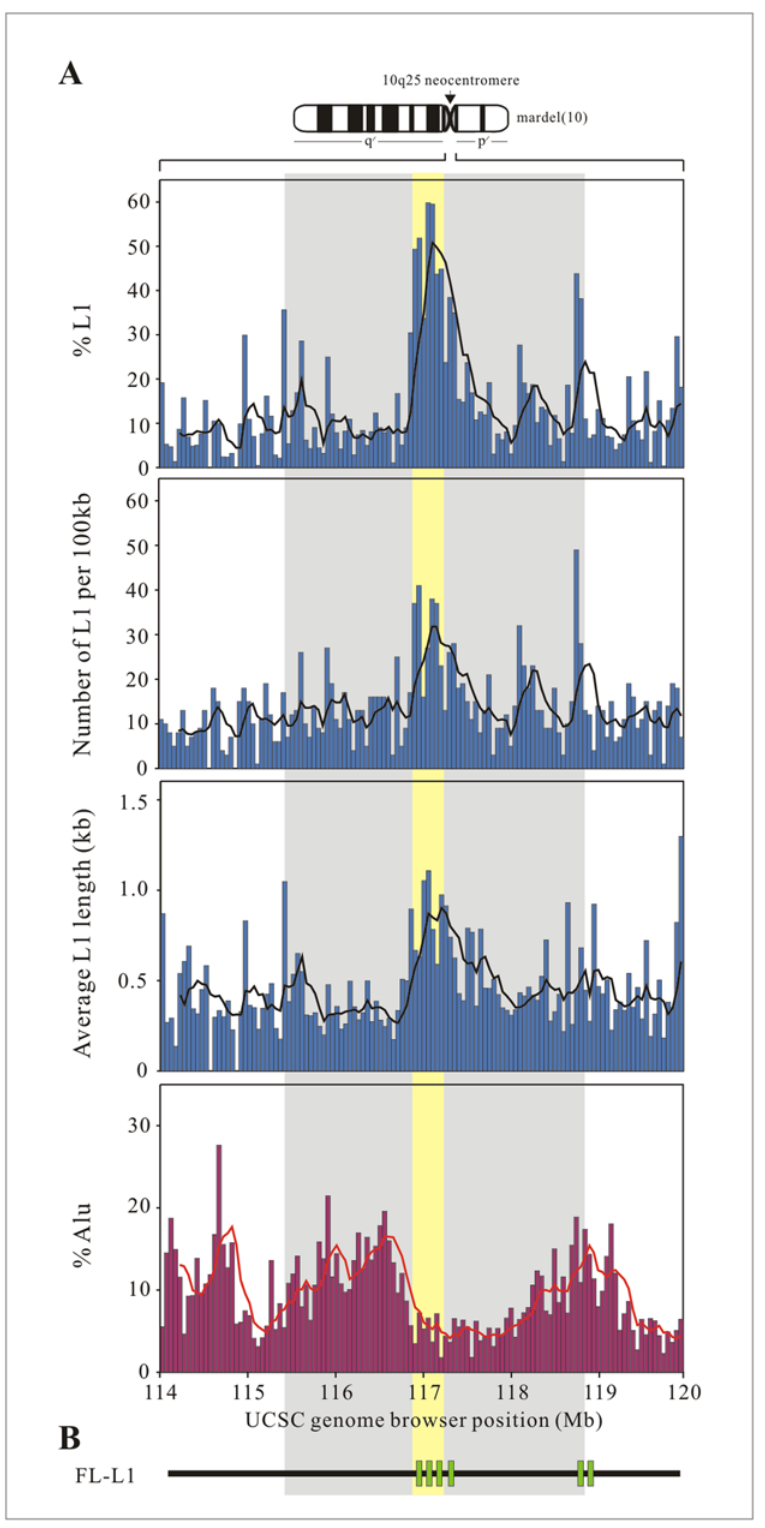
Figure 1. Insilico analysis of the 10q25 neocentromere DNA. (A) Average abundance and length of L1 (or Alu) sequences along a 6-Mb genomic segment spanning the 10q25 neocentromere, encompassing the 330-kb CENP-A-binding domain (shaded in yellow; see Figure 2B for distribution of the seven CENP-A-binding sub-clusters within this domain) and the 3.5-Mb increased chromosomal scaffold (S/MAR)-attachment domain (shaded in grey) [17] analyzed using a 50-kb window. (B) Distribution of full-length L1s (green bars) as identified using the online L1Base program (http://l1base.molgen.mpg.de/).